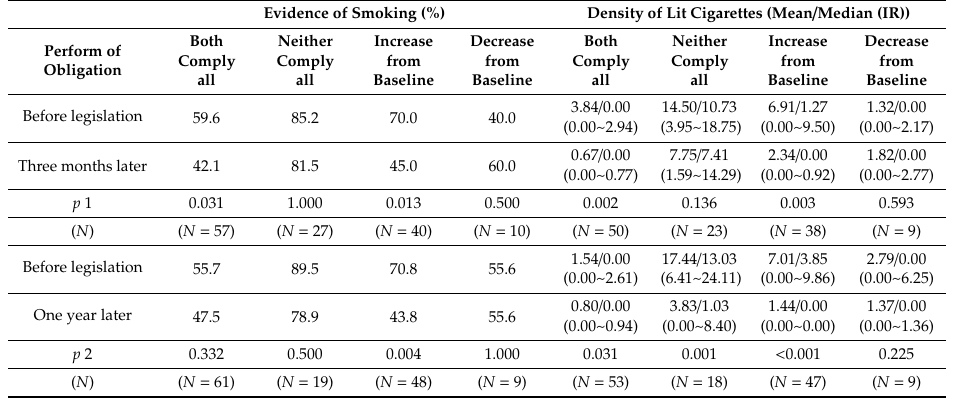
Table 3. Evidence of smoking and density of lit cigarettes following the change of venue manager’s performance of